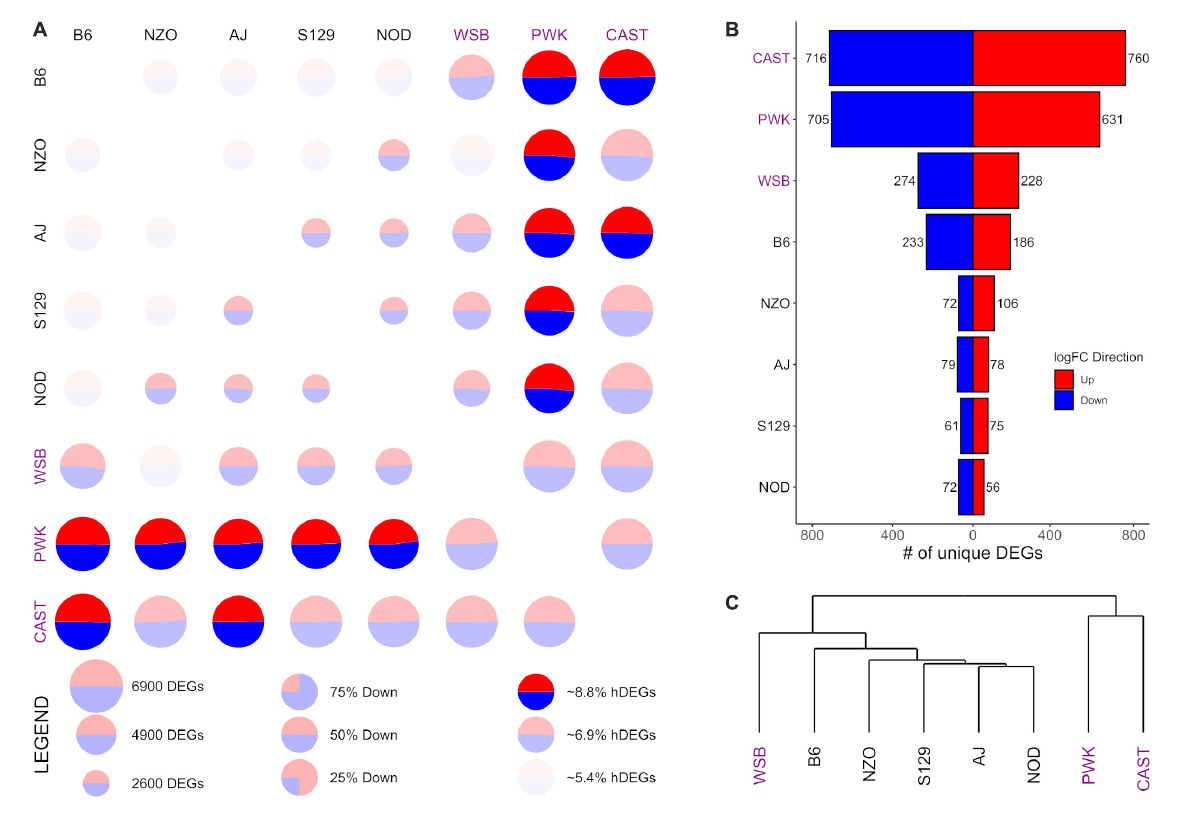
FIGURE4 Differential expression (DE) for prelimbic cortex (PrL) samples from the Collaborative Cross founder strains. Wild-derived strains PWK, CAST, and WSB, denoted by purple text, have the highest number of DEGs, hDEGs (A) , and unique DEGs (B) . B6 demonstrates the highest differentials for total, hDEGs and unique DEGs among the classical inbred laboratory strains. PWK and CAST cluster separately from the other WSB-derived strains in hierarchical clustering (C)